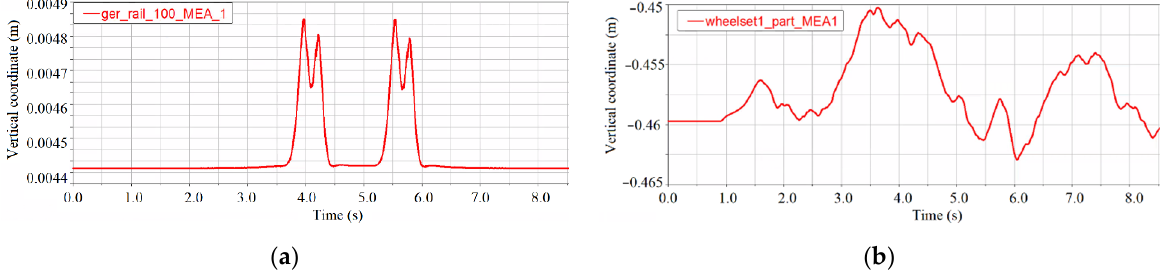
Figure 6. Vibration displacement of the measuring point under the healthy condition of the tunnel: ( a ) vertical vibration displacement of left rail mid-span and ( b ) vertical vibration displacement of the front wheel.